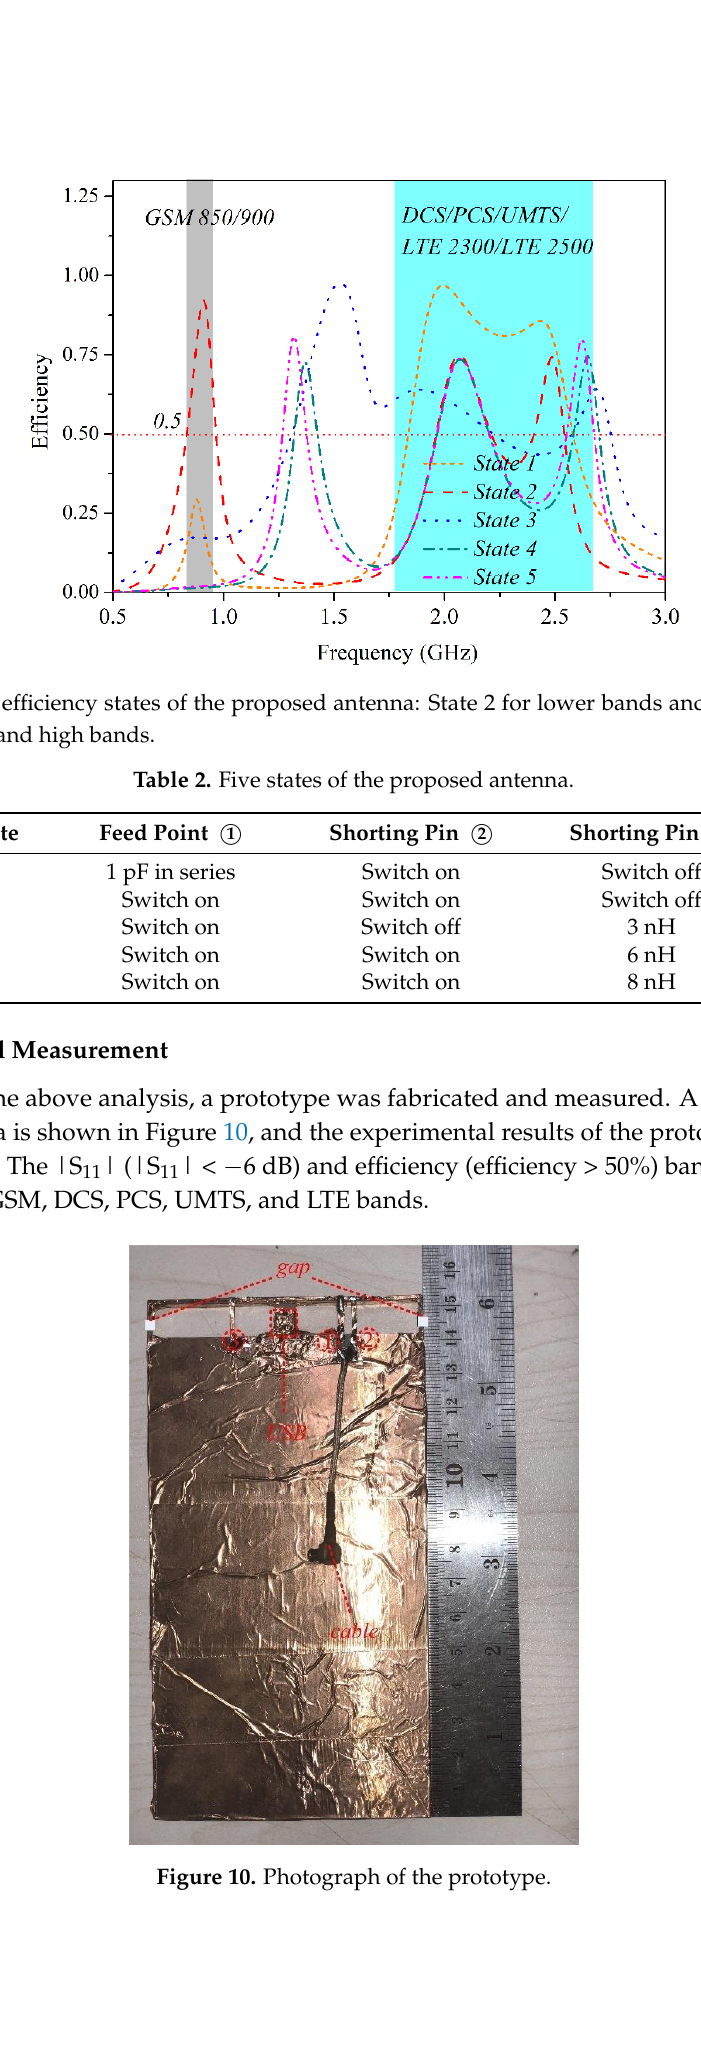
Figure 11. Measured result of five |S 11 |: State 2 for lower bands and the other four states for mid and high bands.